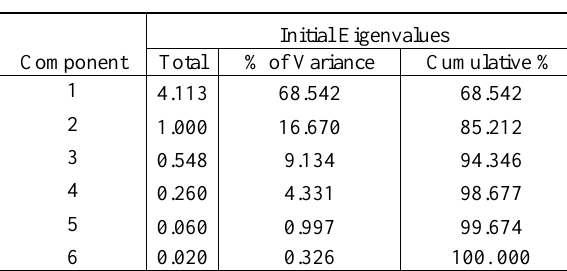
Table 2.Total Variance Explained in PCA